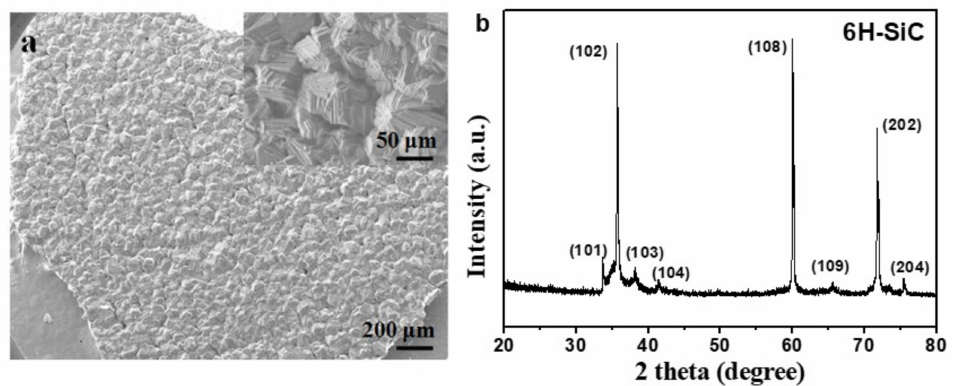
Figure 3. ( a ) SEM images and ( b ) XRD pattern of the deposited SiC product on the graphite crucible cover.